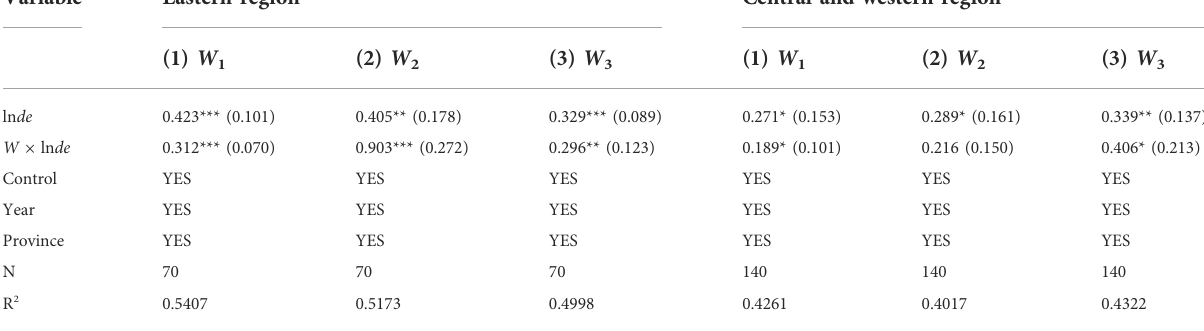
TABLE 9 Regression results of the lag effect.